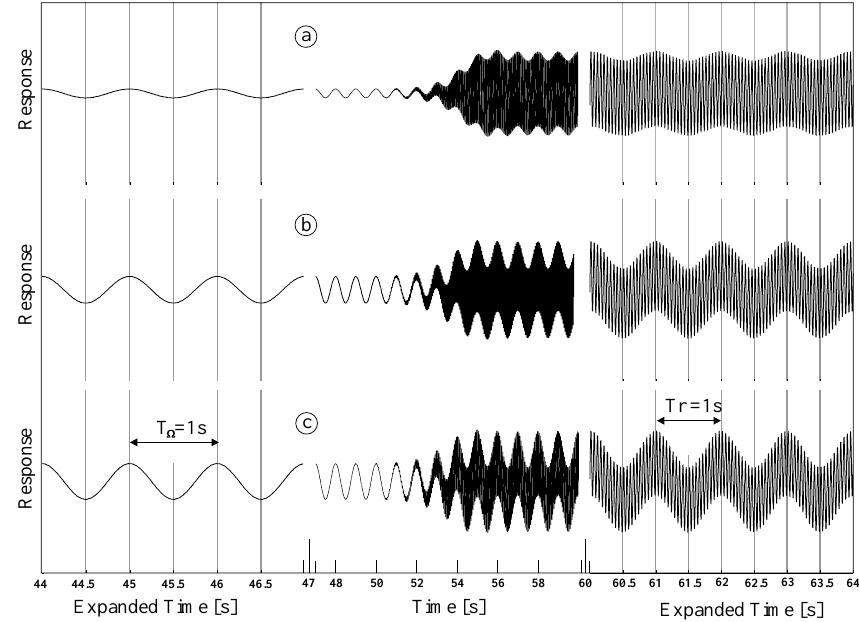
Fig. 16. Predicted system’s dynamic behavior when Ω : ¯ ω n = 1:20: (a) H 6 = 0.47; (b) H 6 = 1.43 and; (c) H 6 = 1.90.